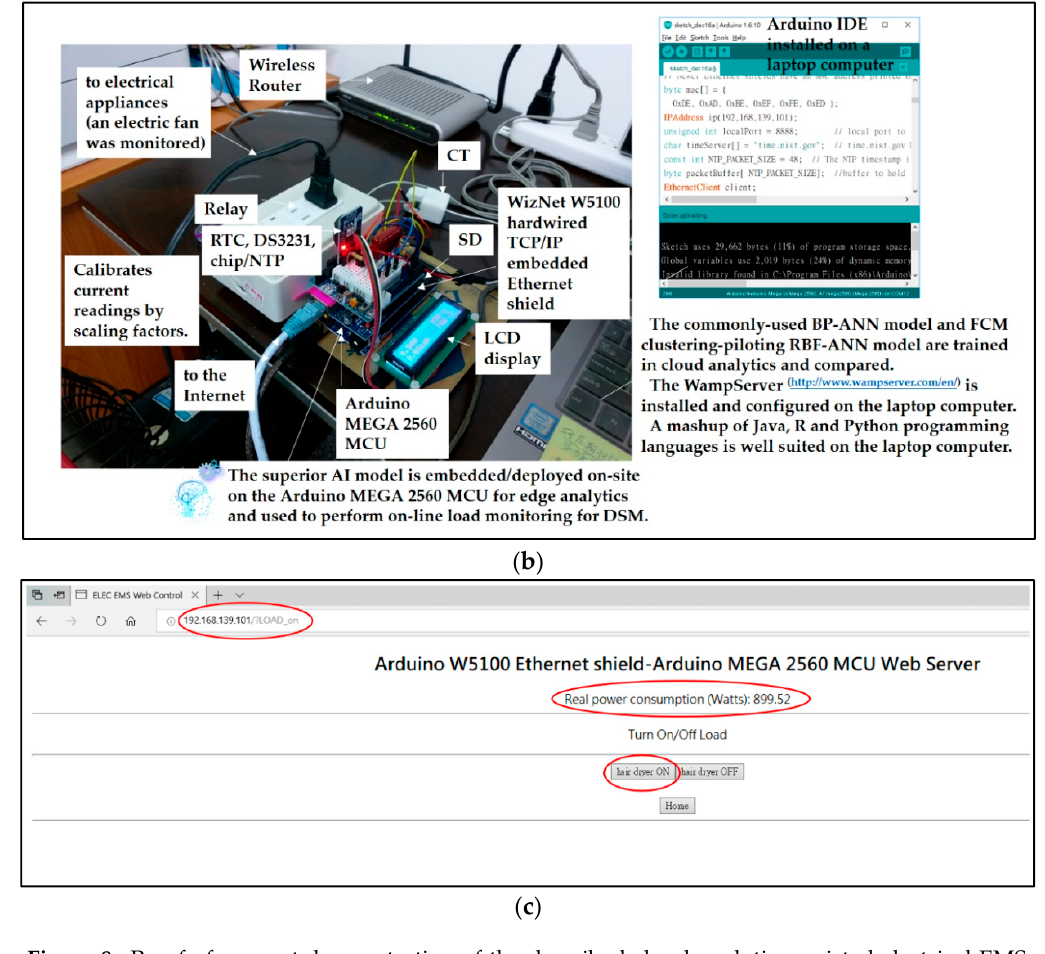
Figure 8. Proof-of-concept demonstration of the described cloud analytics-assisted electrical EMS architecture with the presented AI-embedded and Arduino MCU-based smart power meter prototype, the smart AIoT edge analytics-empowered power meters prototype based on Arduino MCU, as edge analytics for on-line load monitoring as load identification in DSM in this work. ( a ) Sketch of the designed and implemented prototype installed in a practical environment for an electrical network topology and used as a smart electrical outlet/wall socket. ( b ) Experimental set-up of the presented prototype in the described architecture in the realistic laboratory environment. ( c ) Electrical EMS web control: the mobile responsive web server configured on the Arduino MEGA 2560 MCU mounted with the Arduino W5100 ethernet shield and wired with a relay for remote on/off load